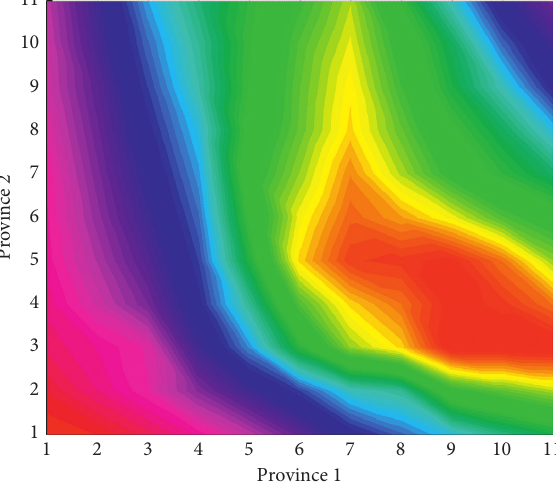
Figure 6: Provinces comparison.